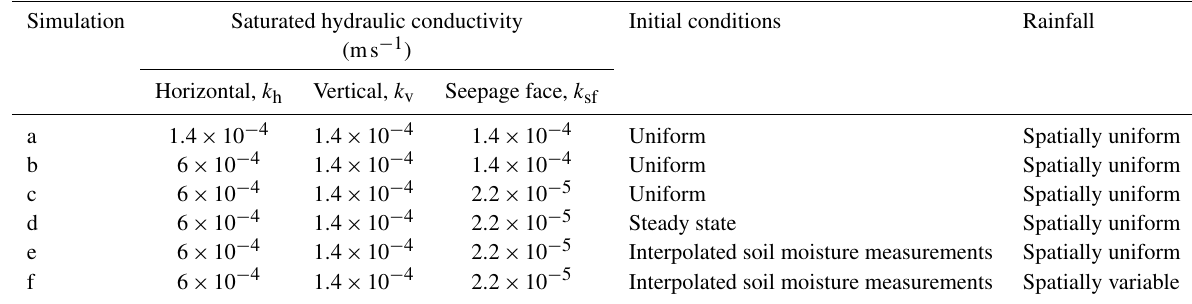
Table 2. Configurations for the six simulations of the integrated flow analysis. Simulation